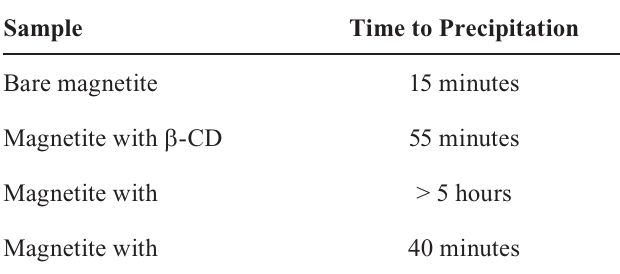
TABLE V - S ettle time for different CDs coated magnetic